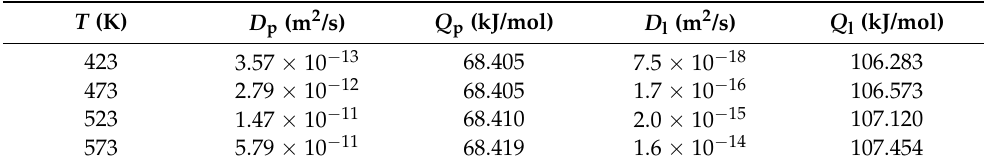
Table 1. The values of diffusivity D and activation energy Q at different temperatures in the present